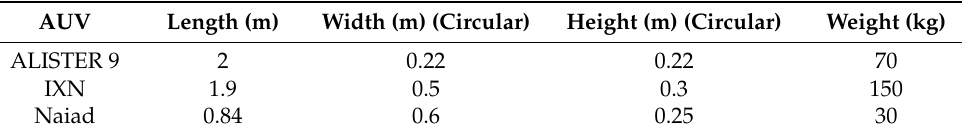
Table 1. Parameters of the AUVs used in the SWARMs project.